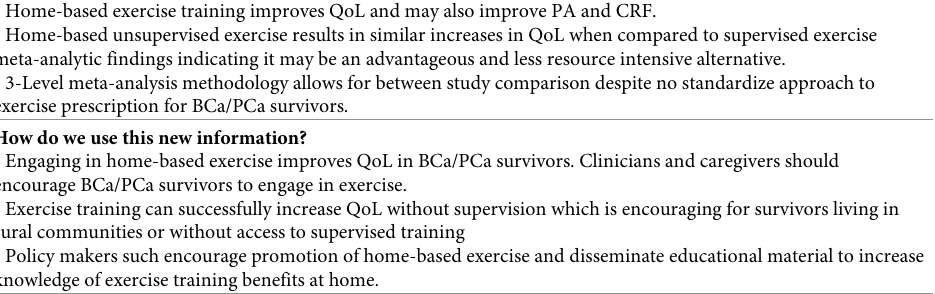
S2 Fig. Funnel plot of observed outcomes (standardized mean difference) for physical activity. Description. Funnel plot constructed using 3-level model. Includes k = 10 studies, u = 14 effect sizes, and total sample of n = 630. Regression intercept test constructed by specify- ing the standard error of the observed outcomes as a moderator in a 3-level model. Interpreta- tion. Inspection of the funnel plot nor the regression test indicated asymmetry (p = 1.000).